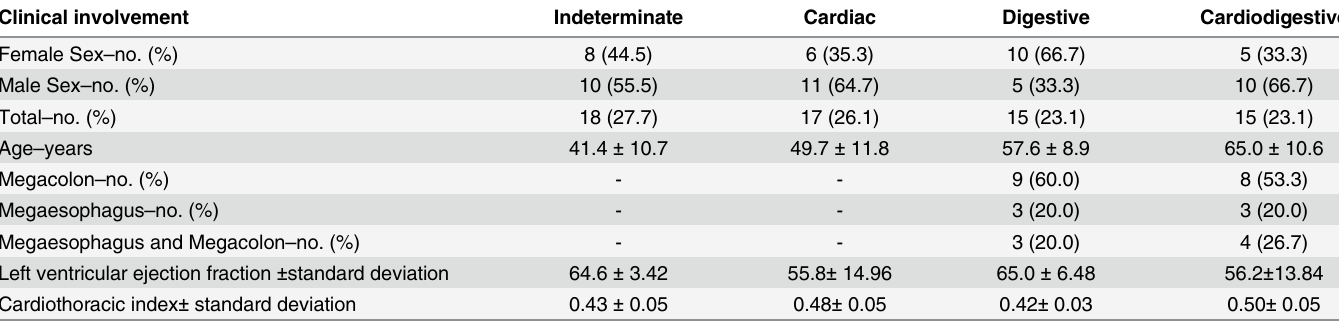
Table 3. Clinical data of chronic chagasic subjects from the Northeast of Brazil included in this